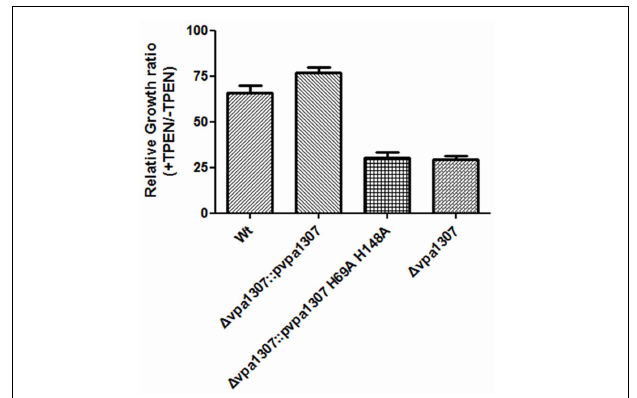
FIGURE 7 | Relative growth rate of different V. parahaemolyticus strains under normal and zinc depletion conditions. Different V. parahaemolyticus strains as indicated were cultured in LB or LB supplemented with 35 μ M TPEN. Their growth (OD600) was monitored at 6h and relative growth rates were calculated as culture grown with TPEN to that of grown without TPEN. The data represents three independent experiments ± the